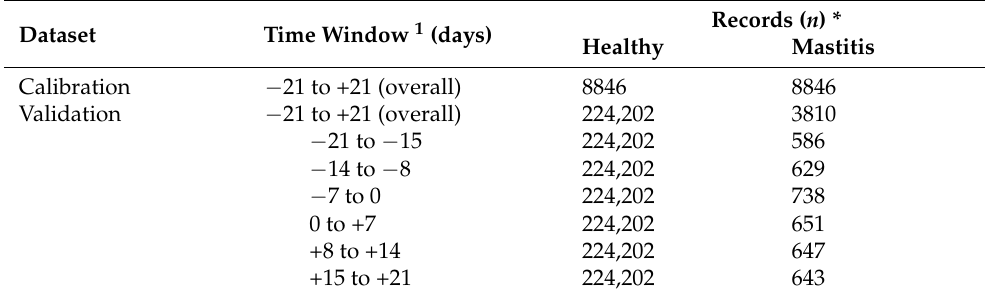
Table 2. Numbers of healthy and mastitis records in the calibration dataset (after random down sampling) and validation dataset (for different time